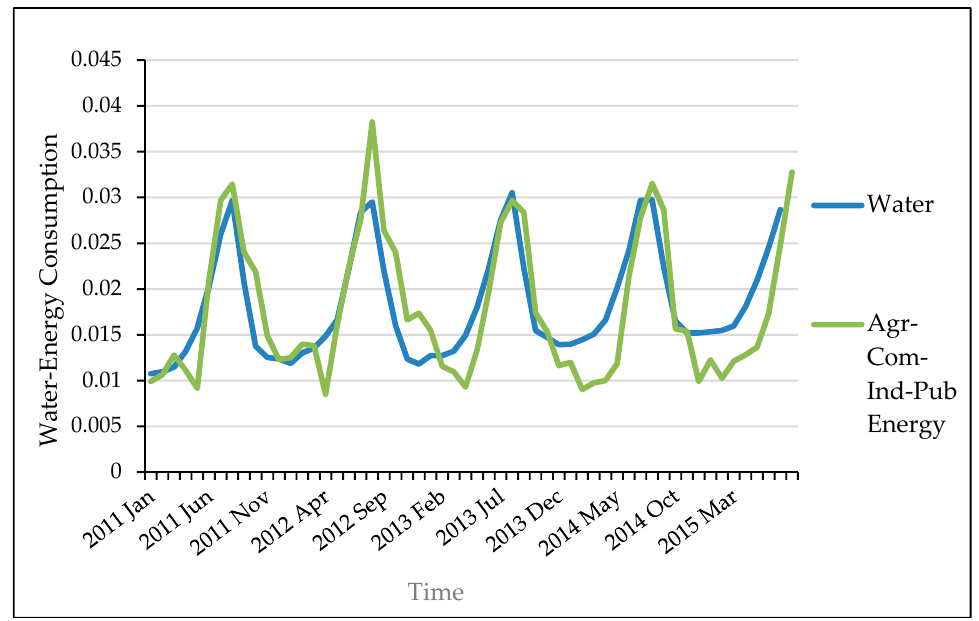
Figure 1. The consumption behavior of total consumption of water in relation to agricultural, commercial, industrial and public use of energy